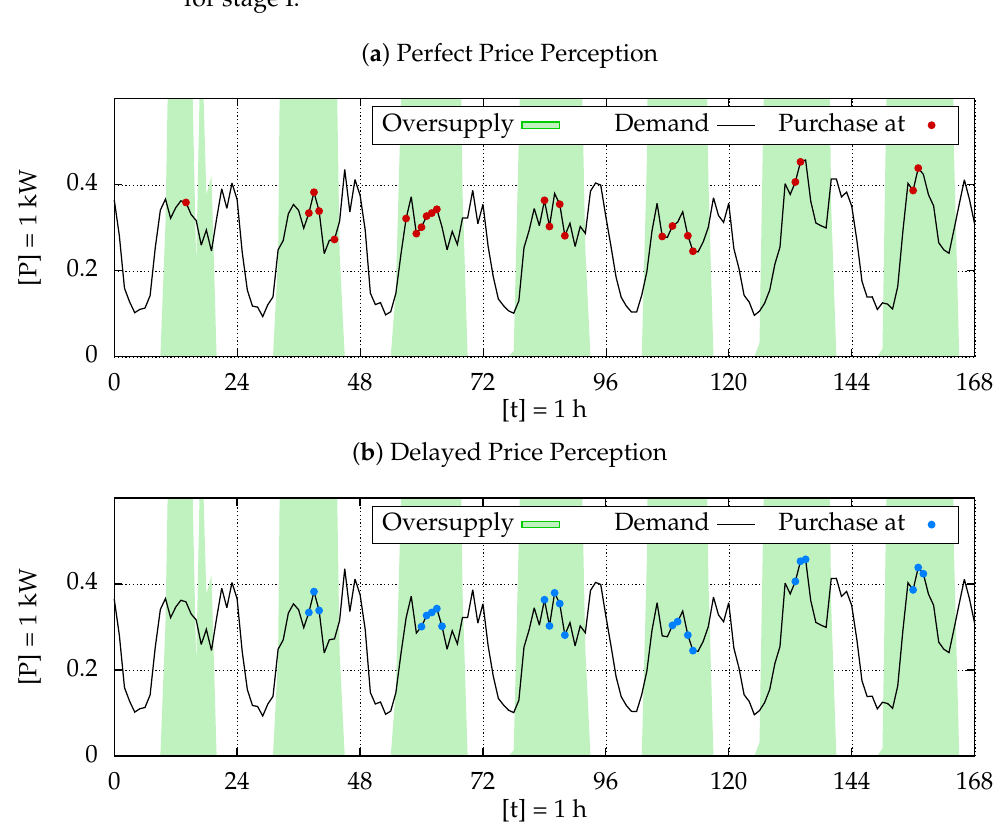
Figure 7. Beneficial price situations for green electricity purchase of an exemplary RSL agent with ( a ) perfect perception ( λ = 1) and ( b ) delayed perception ( λ =